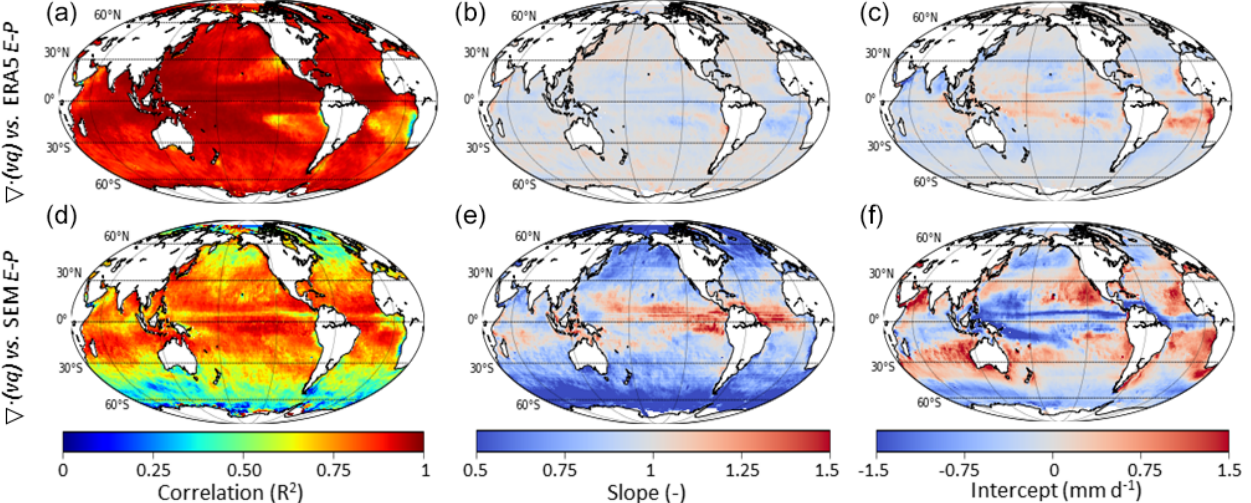
Figure A2. Correlation, slope, and intercept of the linear regression of monthly mean ERA5 ∇ · (vq) with ERA5 E − P (a–c) and with the satellite ensemble median (SEM) E − P (d–f)